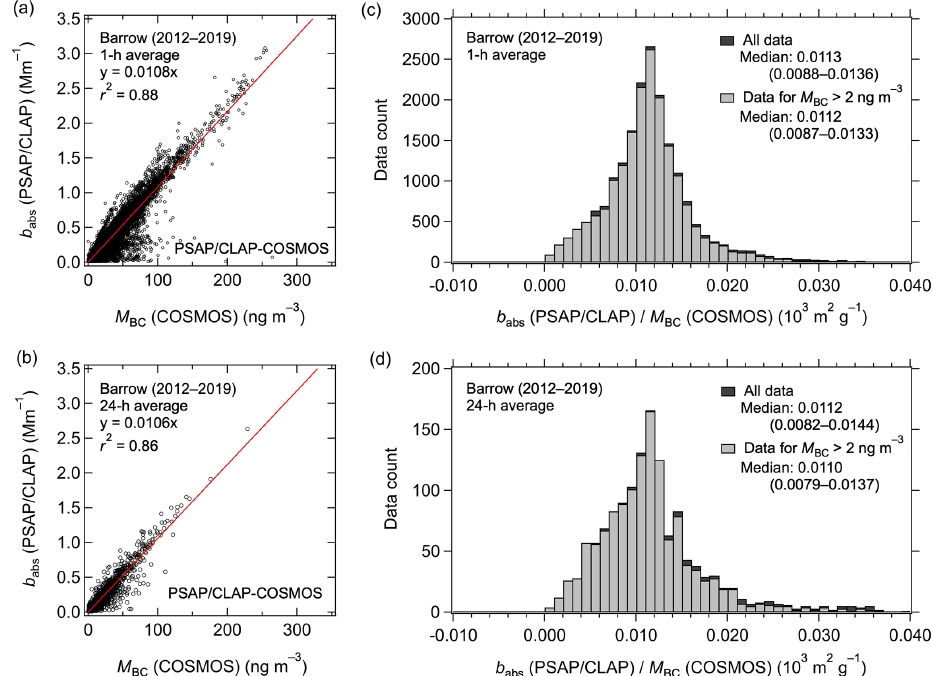
Figure 10. Correlations of M BC (COSMOS) and b abs (PSAP–CLAP; λ = 550nm) from August 2012 to December 2019 at Barrow for (a) 1h averaged and (b) 24h averaged data. The solid red lines are the least-squares regressions forced through the origin. (c, d) Corresponding histograms of b abs (PSAP–CLAP) /M BC (COSMOS) ratios for all data and data with M BC (COSMOS) > 2ngm − 3 .